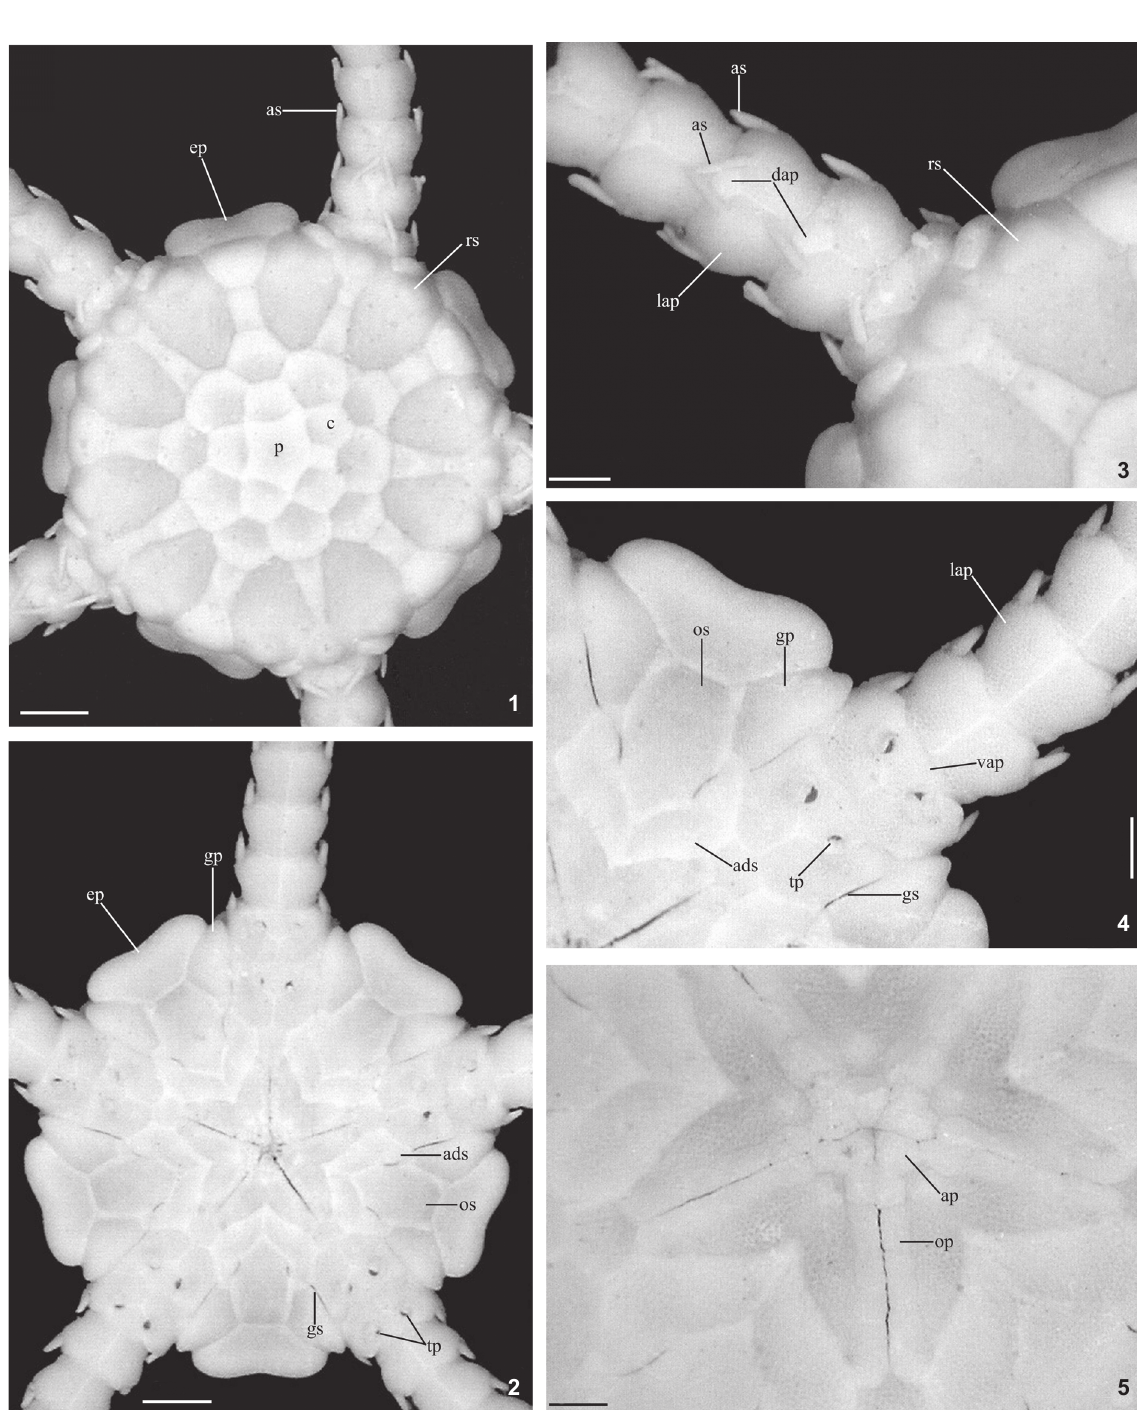
Figures 1-5. Ophiomusium acuferum : (1) dorsal view; (2) ventral view; (3) detail of the dorsal arm; (4) detail of the ventral region (shields and arm); (5) detail of the oral region. (ap) Apical papilla, (ads) adoral shield, (as) arm spine, (c) centrodorsal plate, (dap) dorsal arm plate, (ep) enlarged plate, (gp) genital plate, (gs) genital slip, (lap) lateral arm plate, (op) oral papilla, (os) oral shield, (p) primary plate, (rs) radial shield, (tp) tentacle pore, (vap) ventral arm plate. Scale bars: 1-2 = 1 mm, 3-4 = 0.5 mm, 5 = 0.3